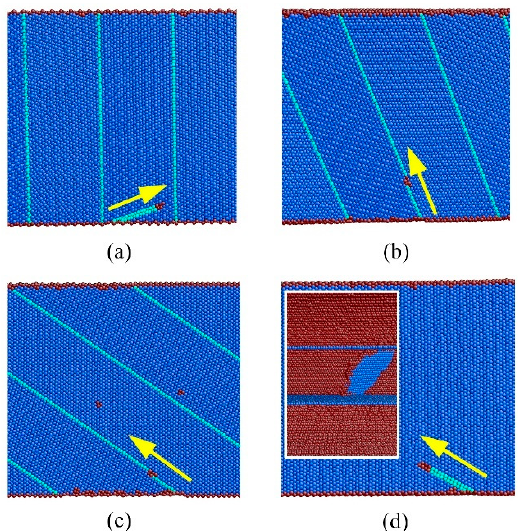
Figure 6. Cross-section views of atomic snapshot at yield point in NT nanowires with λ = 5.45 nm and θ = ( a ) 0 ◦ , ( b ) 19.47 ◦ , ( c ) 54.74 ◦ , and ( d ) 90 ◦ . The atoms are colored according to the CNA. The blue, sky blue, and red atoms are atoms with FCC, HCP lattice and defective atoms, respectively. The insert in ( d ) shows the side cross-sectional view in which the atoms with FCC lattice are hid, and blue and red atoms are HCP and other atoms.